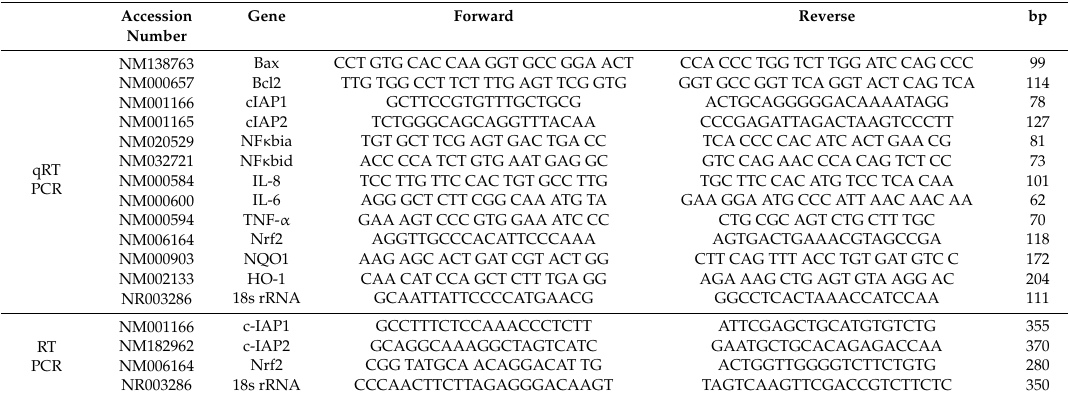
Table 2. List of